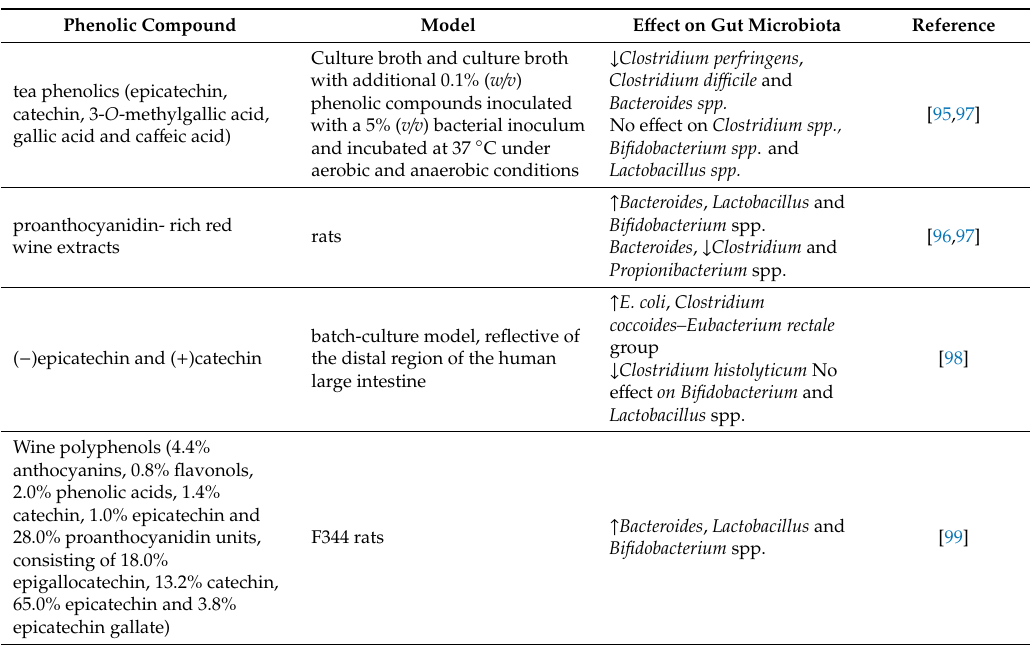
Table 2. E ff ects of polyphenols on gut microbiota. ↑ indicates an increase in bacteria population; ↓ indicates a decrease in bacteria